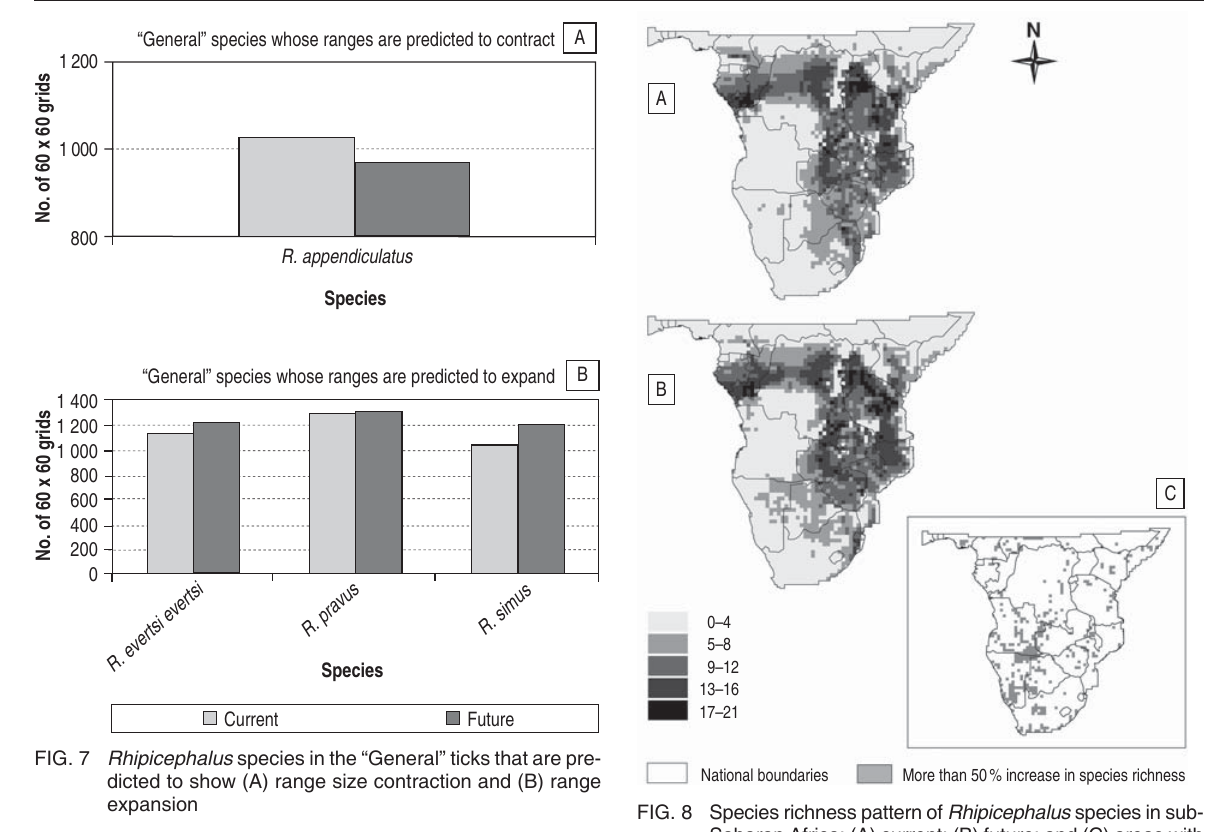
Saharan Africa: (A) current; (B) future; and (C) areas with more than 50 %